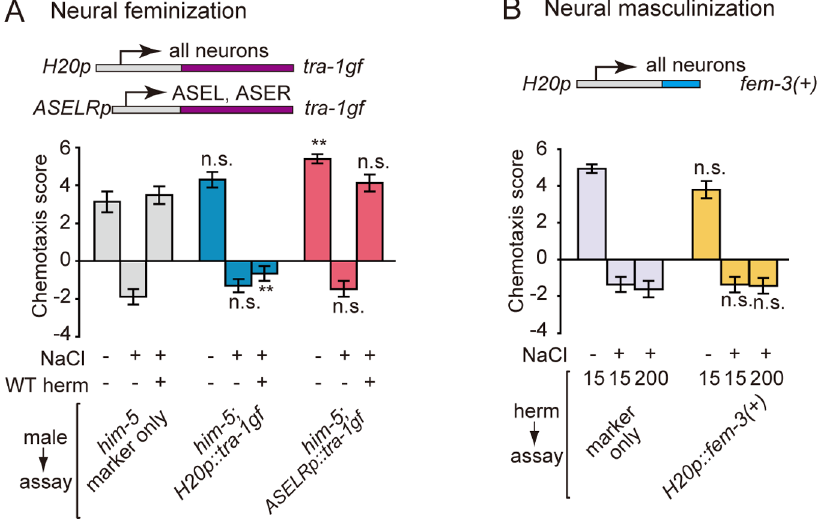
Figure 5. The impact of tissue- and cell-specific sex conversion on sexual conditioning. (A) tra-1(gf) was expressed in all neurons by the H20 promoter or in ASE neurons by the gcy-5 and gcy-7 promoters to feminize the respective neurons of males, which were conditioned with the WT hermaphrodites. Males with feminized neurons are not attracted to NaCl after being conditioned with hermaphrodites. (B) Overexpression of fem-3( + ) under the control of the H20 promoter to masculinize all neurons. The transgenic hermaphrodites were conditioned in a high-density population, but this procedure does not cause sexual conditioning. **, P , 0.001; n.s., not significant. Error bars represent SEM. n=56–64 animals for each condition.